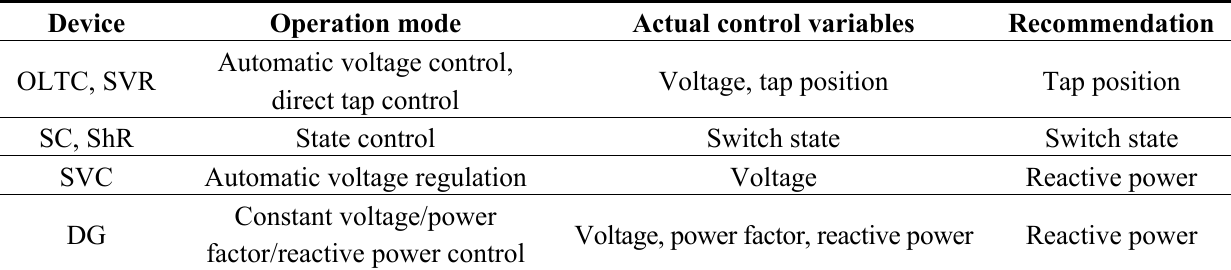
Table 4. Control values of controlling devices for each operation mode, and recommendation values of the VVO. ShR: shunt